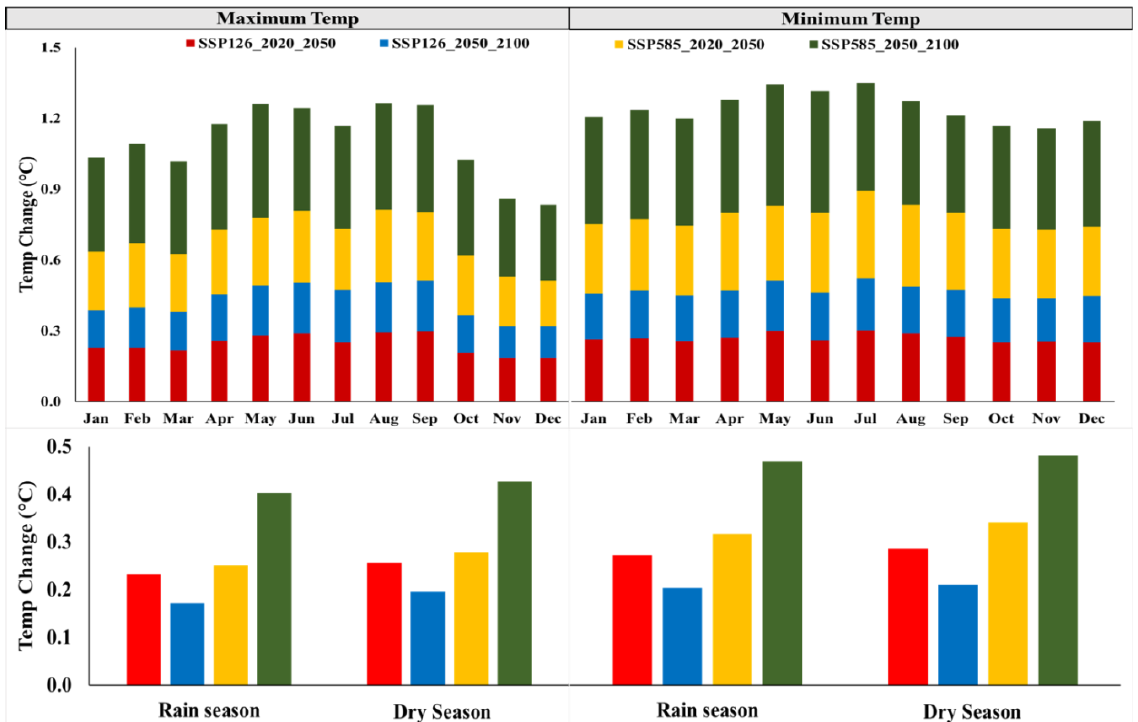
Figure 4. Absolute change in maximum and minimum temperatures; the upper plot shows monthly changes, while the lower plot shows seasonal changes.